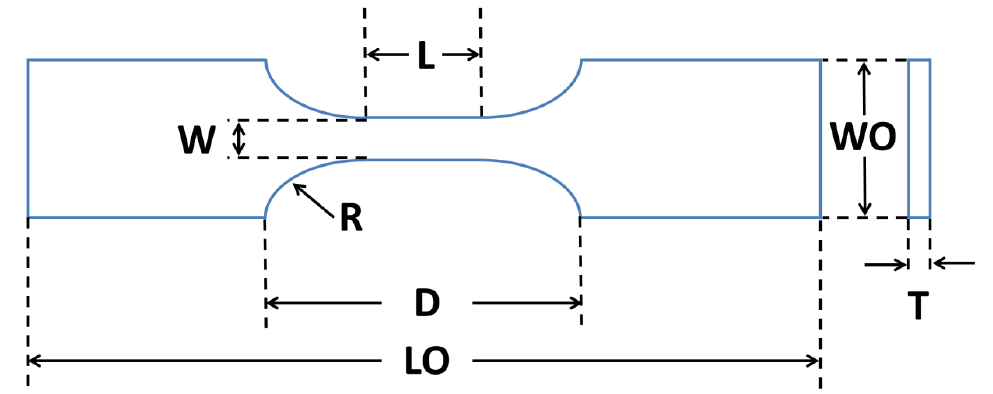
Figure 1. A dog-bone-shaped sample for the fatigue test. Table 1. Dimensions of the dog-bone sample